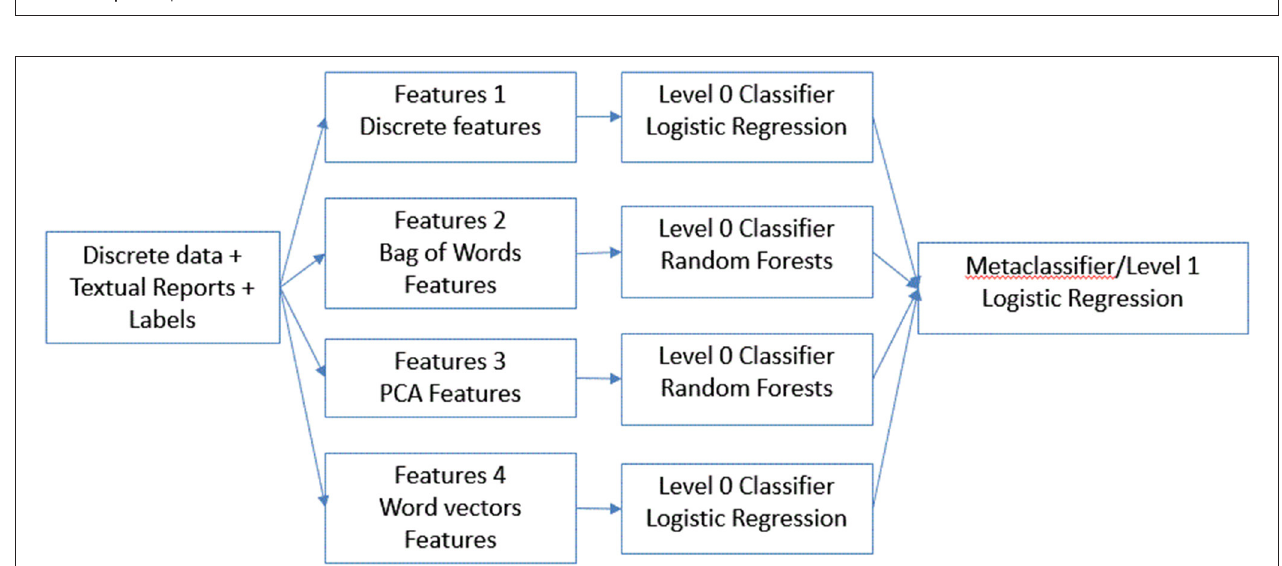
FIGURE 1 | Description of feature ensemble method.